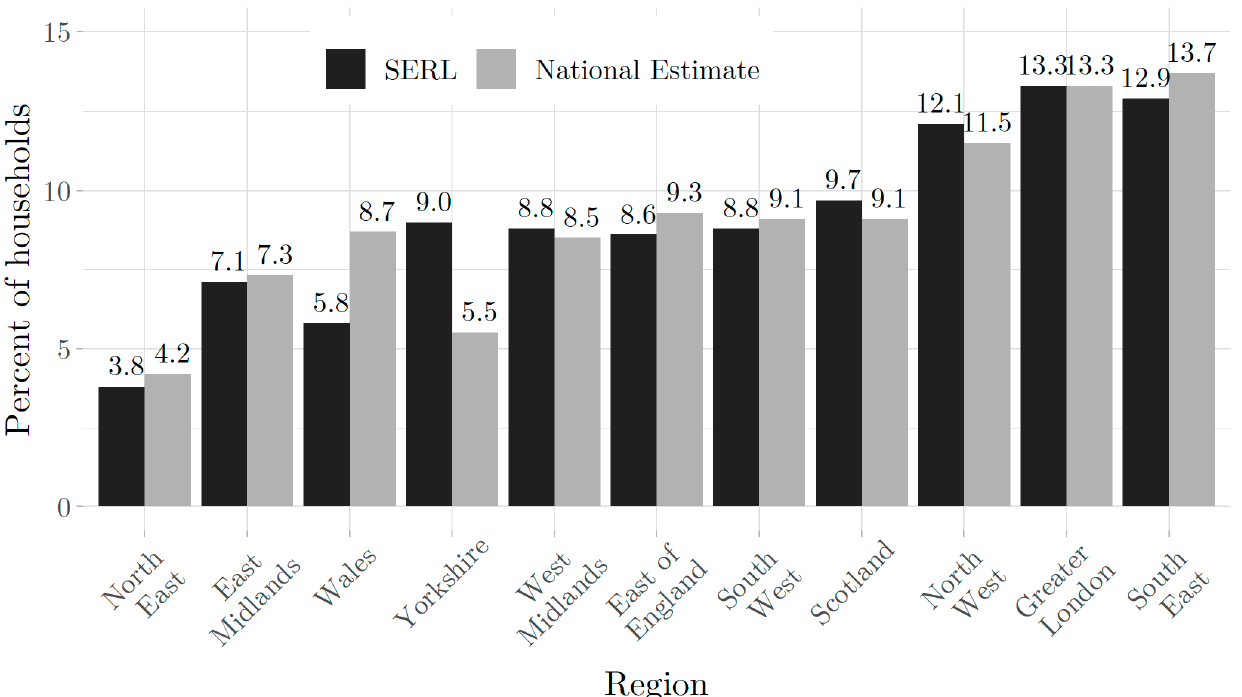
Figure 7. Percentage of the SERL Observatory in each GB region compared with our national estimate from Address Base.